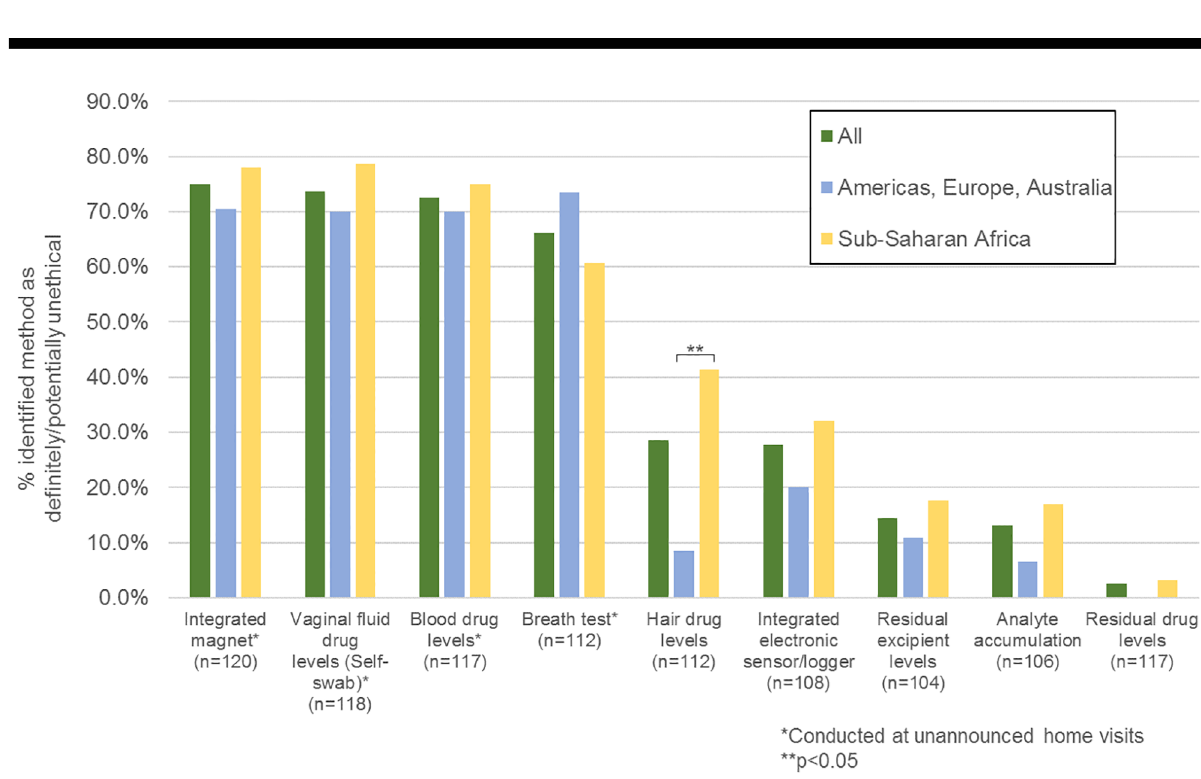
Fig 4. Ethical concerns for methods by